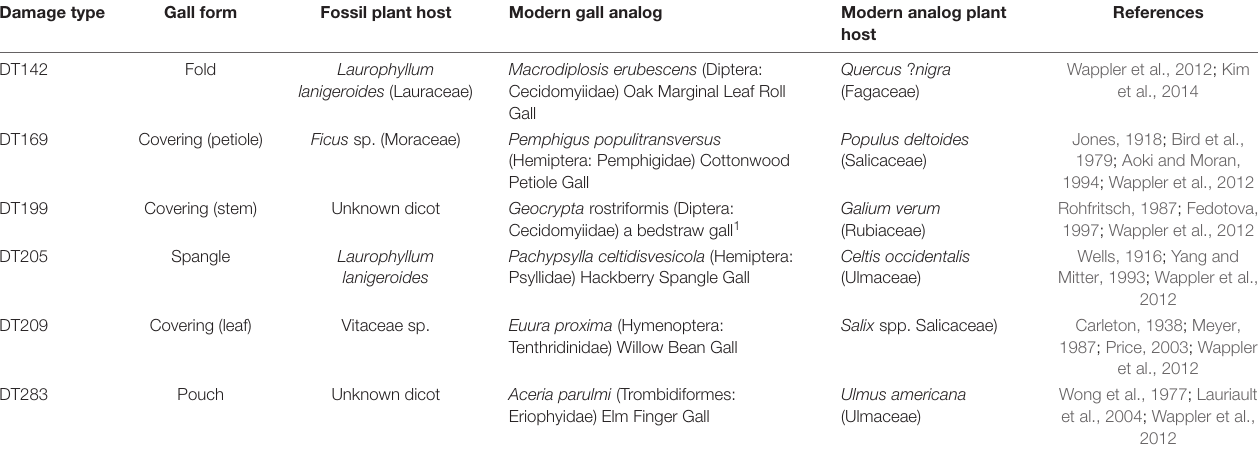
TABLE 2 | Fossil damage types (DTs) and their modern analogs, with plant-host data, from the Eocene Messel Formation (47.8 Ma) of Germany. Damage